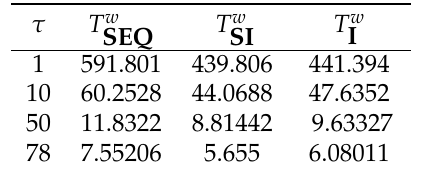
Table 5. Comparison of computational wall clock time T w [ s ] for the three model variants and different time steps, for the base case and T = 25 K